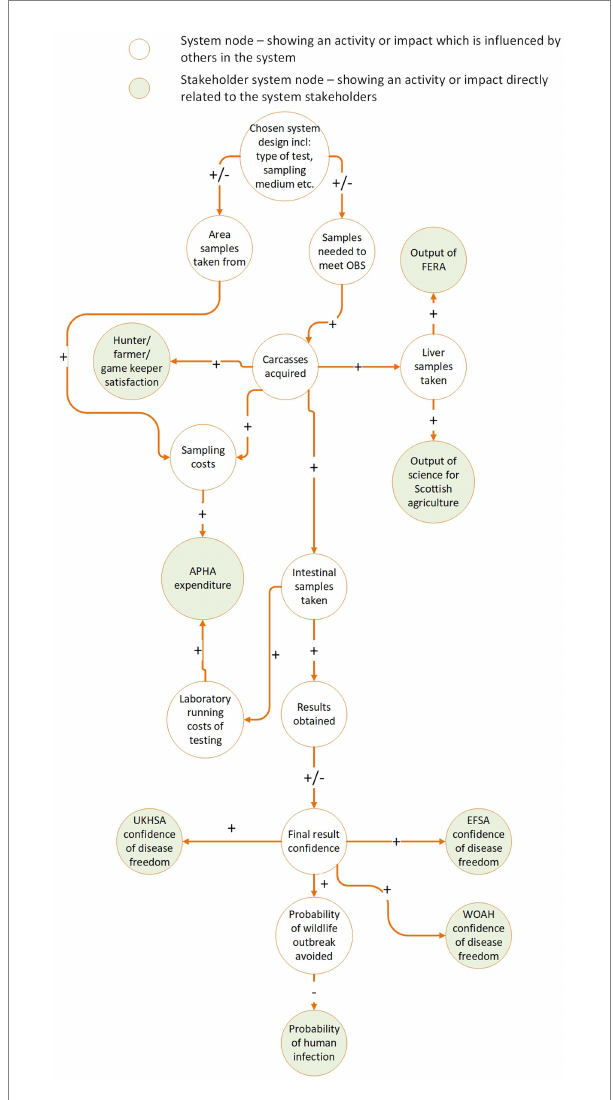
FIGURE 3 Example causal loop diagram illustrating the positive and negative interrelationships of different parts of the UK E. multilocularis surveillance system and the perceived stakeholder benefits and losses from changing aspects of the